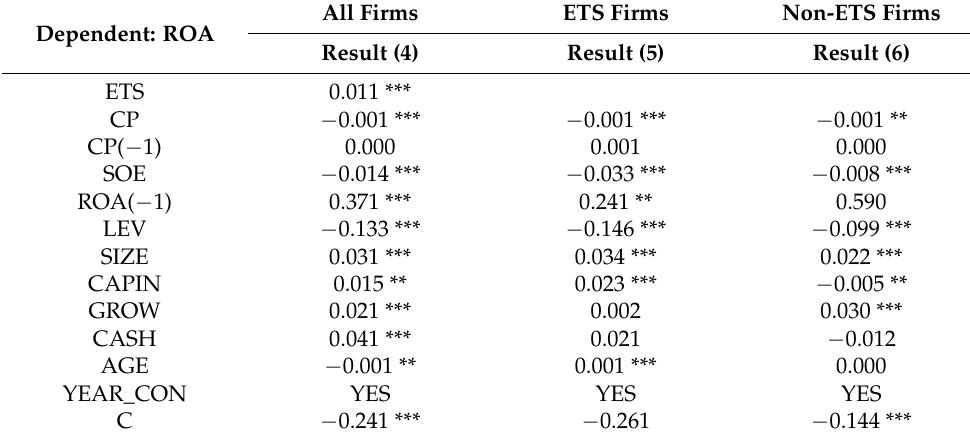
Table 9. Regression results: Equation (2). All Firms ETS Firms Non-ETS Firms Dependent: ROA Result (4) Result (5) Result